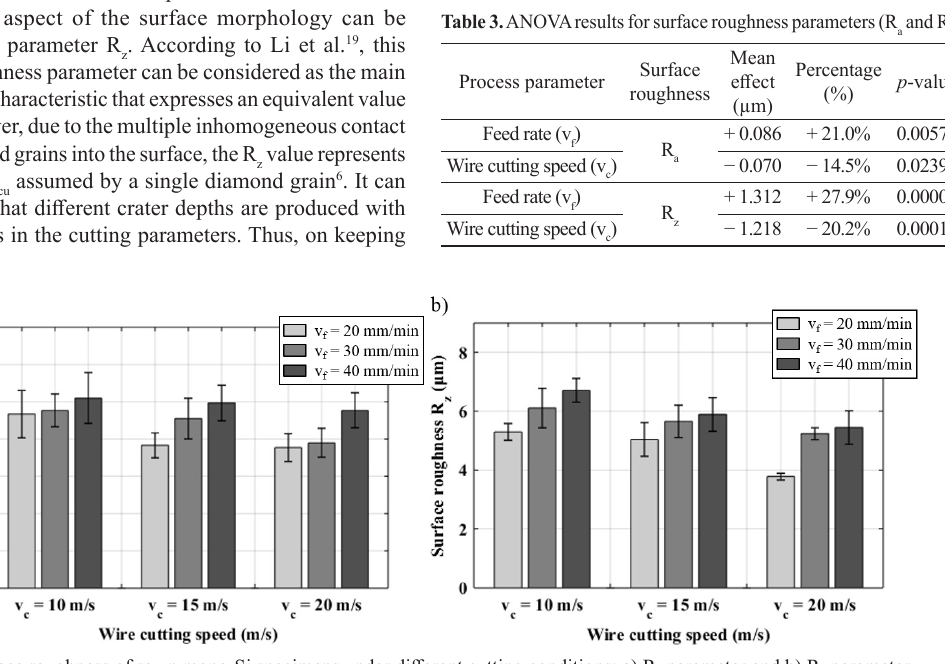
Figure 7. Surface roughness of sawn mono-Si specimens under different cutting conditions: a) R